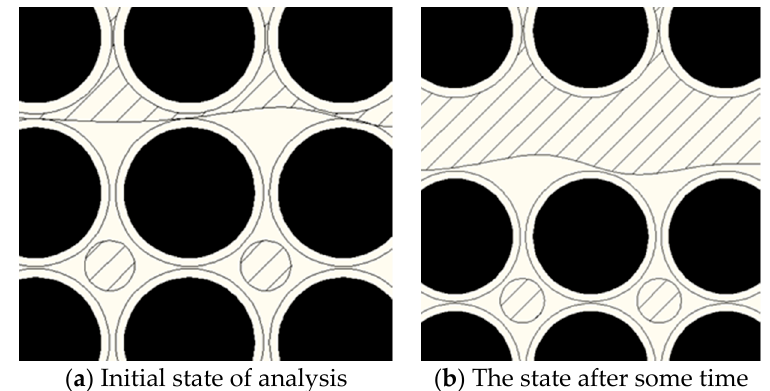
Figure 5. Schematic of freezing soil whose temperature gradient is small: soil grains, the circles filled with black shadow; ice crystals, the circles or ellipses with slashed shadow; the ice block, the slashed shadow area; the thin unfrozen water film, the annulus outside the filled circle; the curve represents the potential position x sep of the ice lens; and the other symbols represent the unfrozen water.